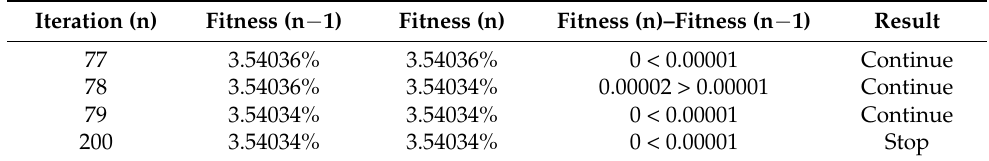
Table 8. Detailed optimization calculation process.